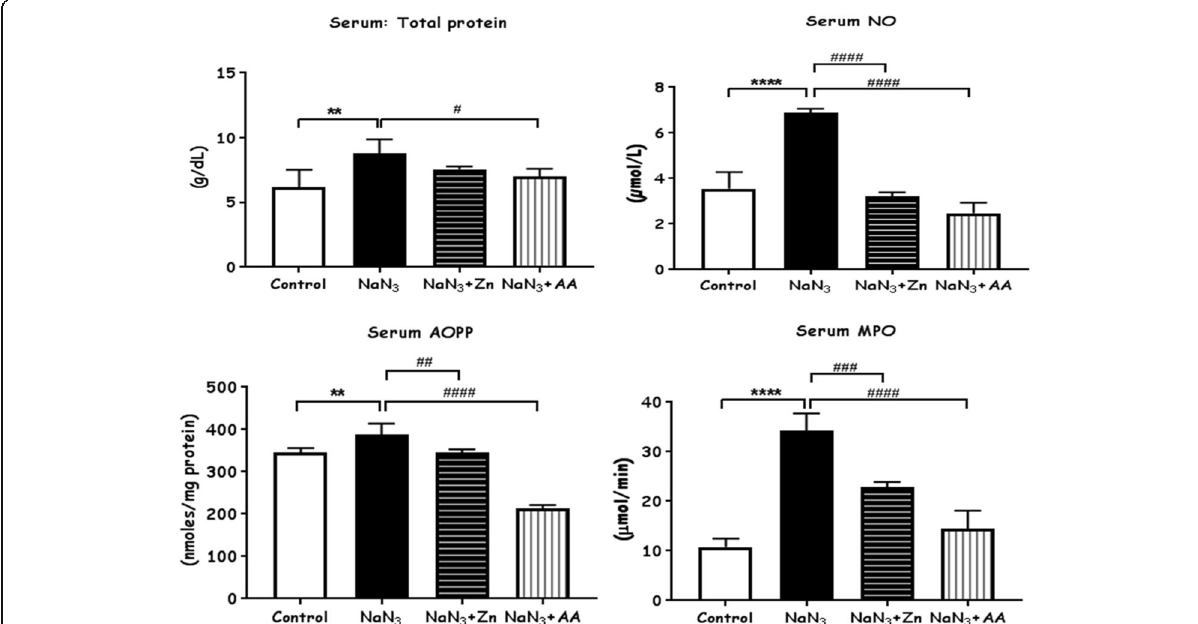
Fig. 1 The effects of Zn sulphate (Zn) and AsA (AA) on serum protein, nitric oxide (NO), advanced oxidation protein products (AOPP) levels and myeloperoxidase (MPO) activity in rats treated with sodium azide (NaN 3 ). Values are given as mean ± standard deviation ( n = 7). Significant differences: *NaN 3 ; NaN 3 + Zn; NaN 3 + AA versus control group (* p < 0.05; ** p < 0.01; *** p < 0.001; **** p < 0.0001). # NaN 3 + Zn; NaN 3 + AA versus NaN 3 group ( # p < 0.05; ## p < 0.01; ### p < 0.001; #### p <